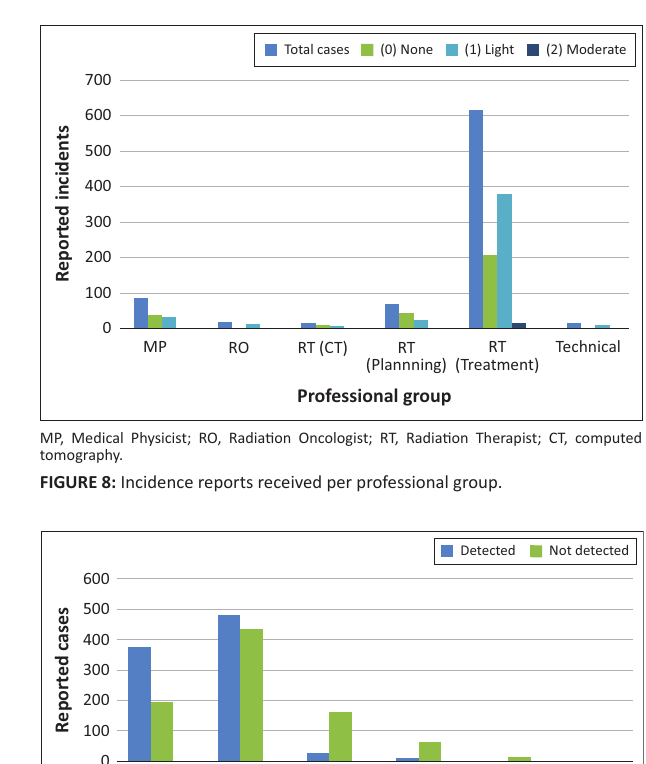
FIGURE 7: Percentage incidence reports received per professional group.